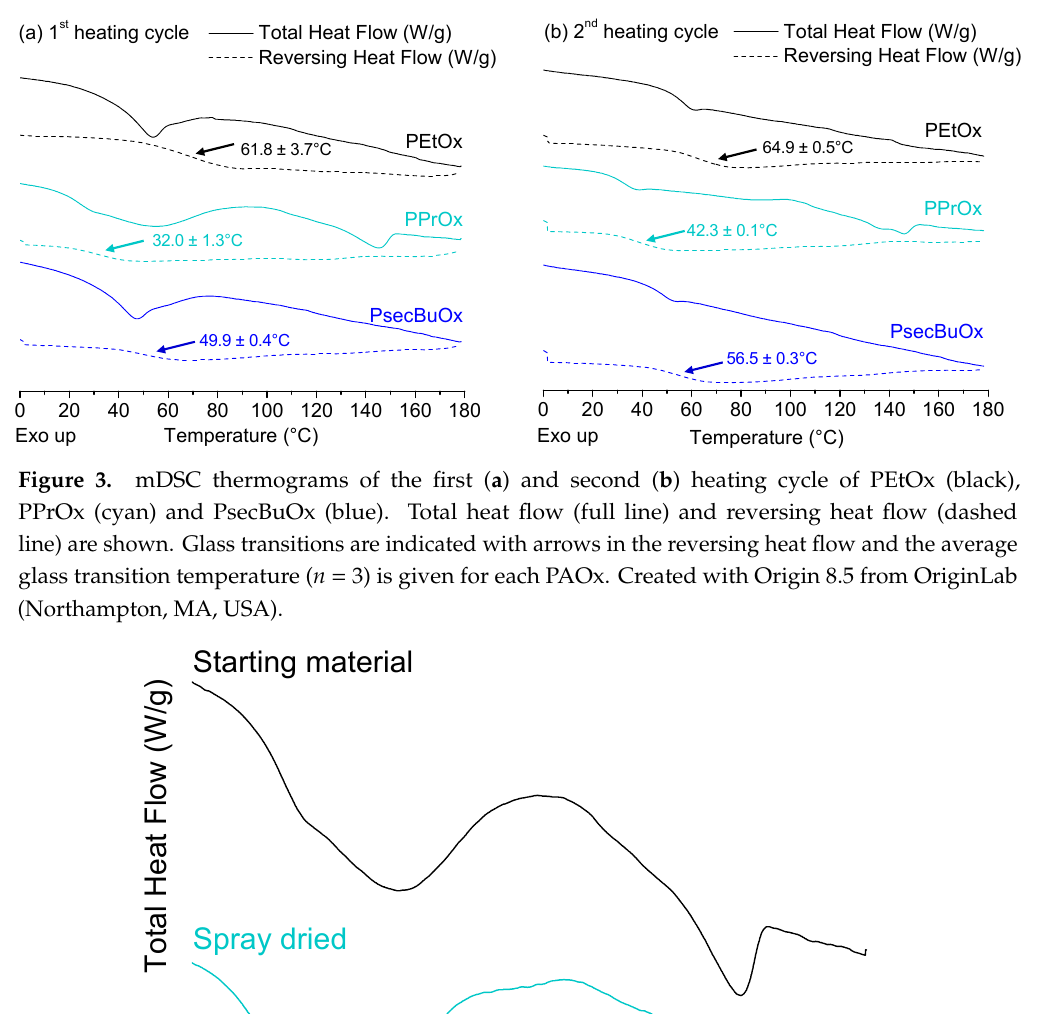
Figure 3. mDSC thermograms of the first ( a ) and second ( b ) heating cycle of PEtOx (black), PPrOx (cyan) and PsecBuOx (blue). Total heat flow (full line) and reversing heat flow (dashed line) are shown. Glass transitions are indicated with arrows in the reversing heat flow and the average glass transition temperature ( n = 3) is given for each PAOx. Created with Origin 8.5 from OriginLab (Northampton, Massachusetts, USA).